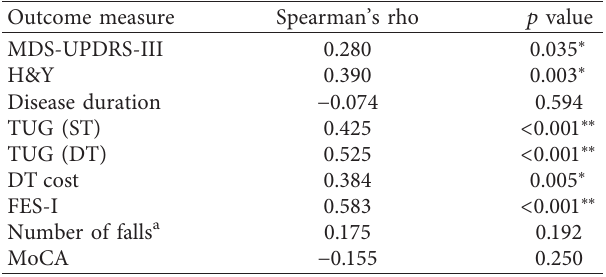
Table 3: Correlations of NFOG-Q with other outcome measures ( n � 57).